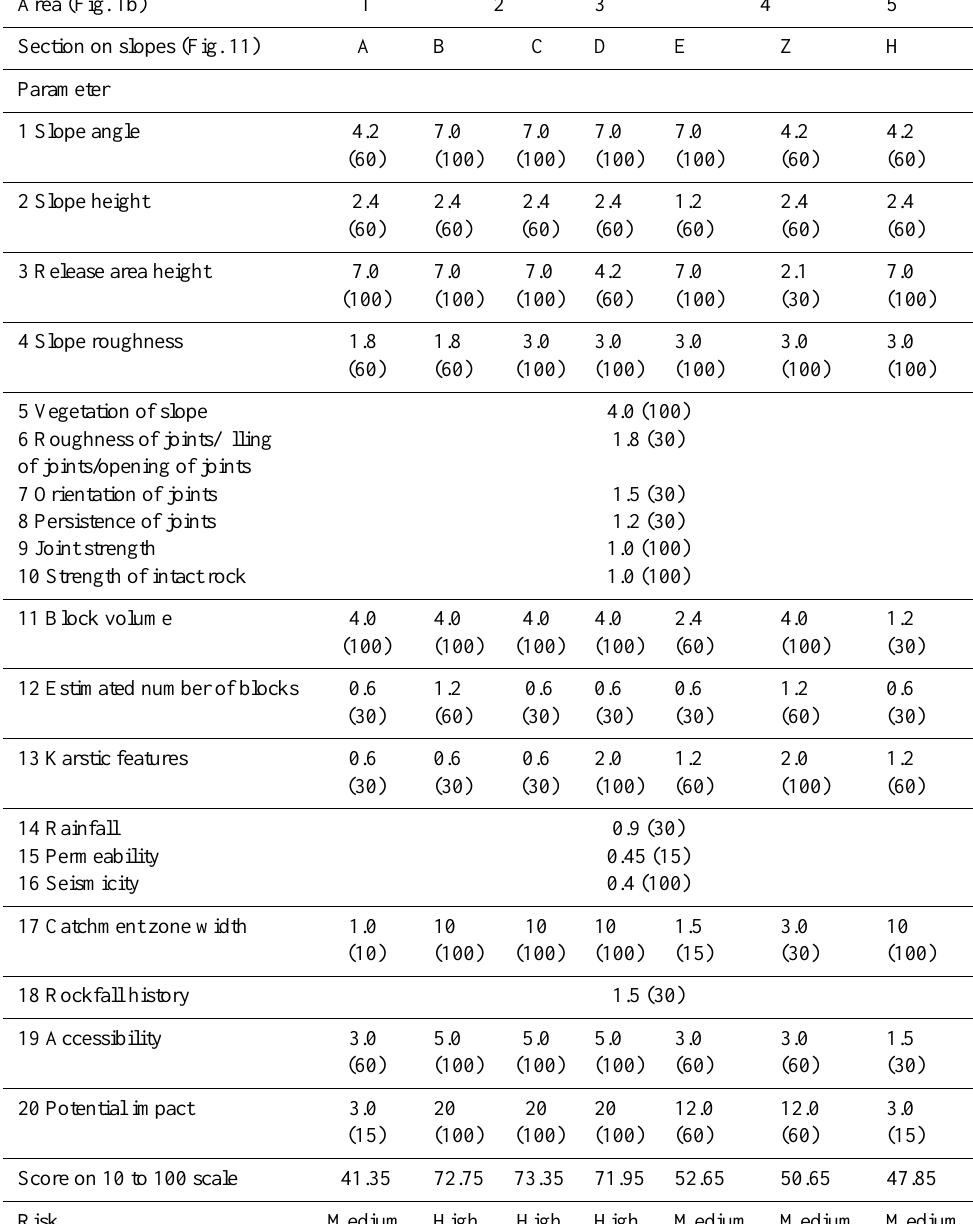
High High High Medium Medium Medium